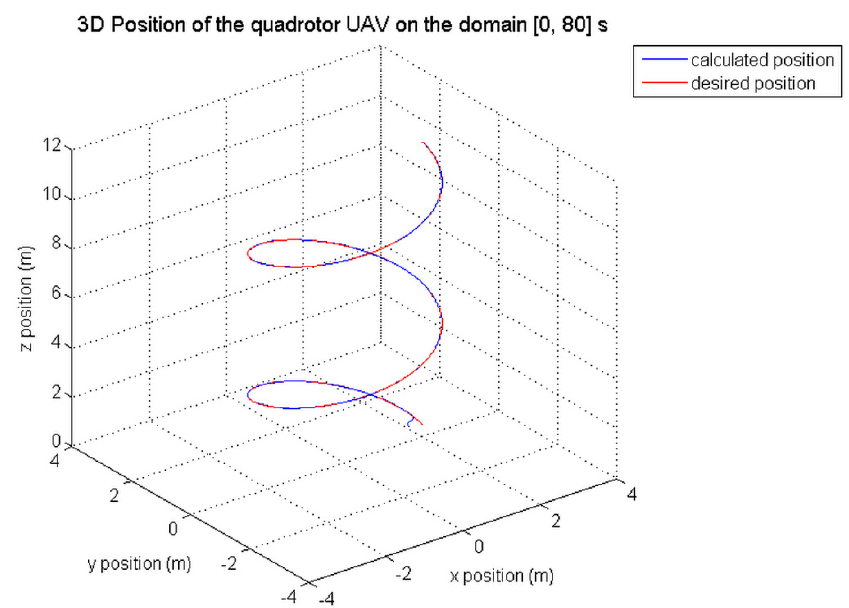
Figure 23. The 3D position of the quadrotor UAV obtained by the PTCM in the time interval [0, 80] s.